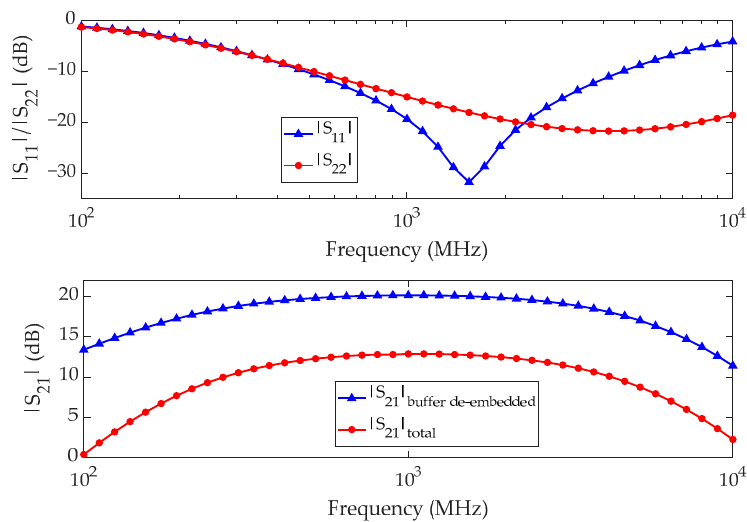
Figure 5. Simulation results for input/output matching (|𝑆 (cid:2869)(cid:2869) |/|𝑆 (cid:2870)(cid:2870) | ) and power gain (|𝑆 (cid:2870)(cid:2869) | ).